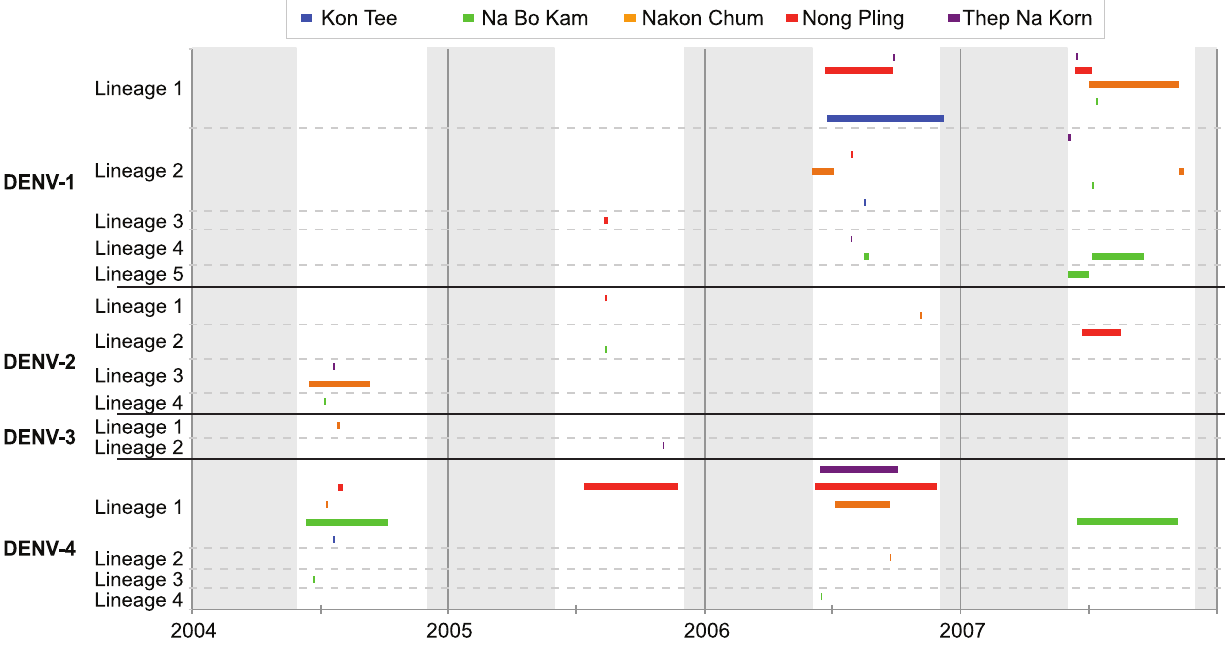
Figure 3. Timing of DENV lineages circulating in five participating sub-districts of KPP, Thailand from 2004–2007. Horizontal bars indicate the time period in which specified lineages were isolated during school-based surveillance (conducted from June to November). Vertical grey bars indicate periods of the year in which cohort sampling was inactive (December to May).